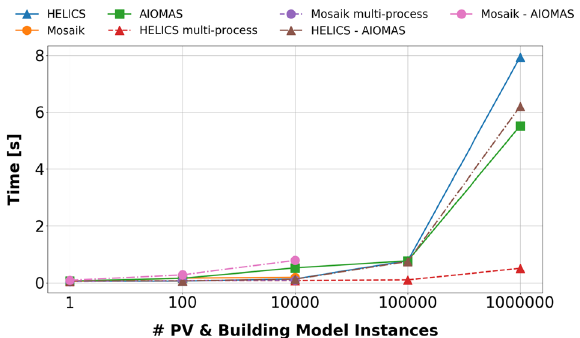
Fig. 9 Average time step duration of the different co-simulation frameworks and their configurations